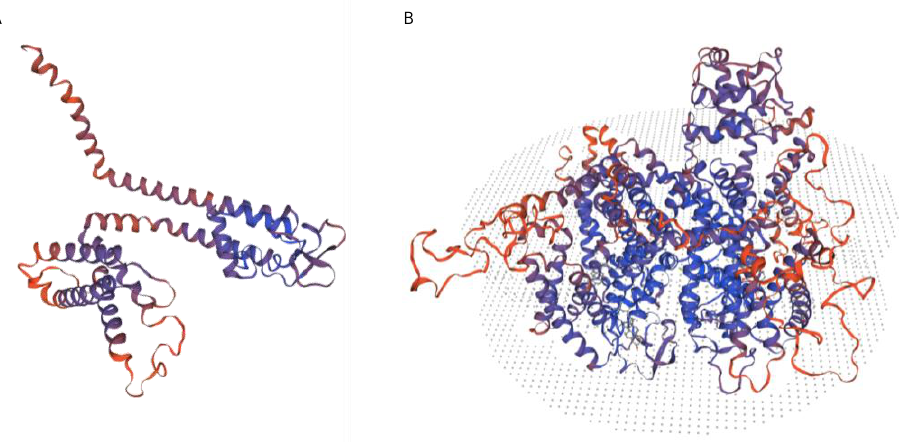
Table 1. Identified CACNA1D variants of 21 ALS patients.